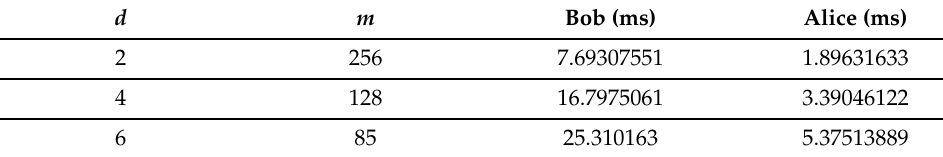
Table 7. Calculation time (ms) for Alice and Bob when n = 1024.